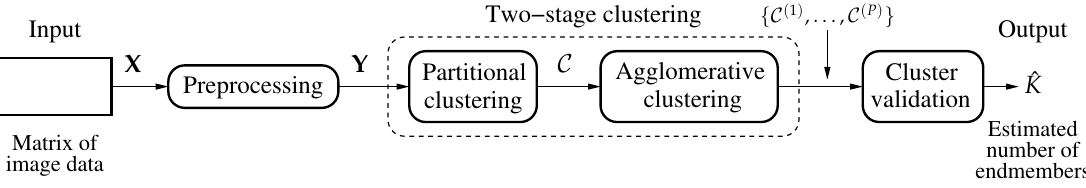
Figure 1. Overview of the proposed method for the estimation of the number of endmembers of a hyperspectral